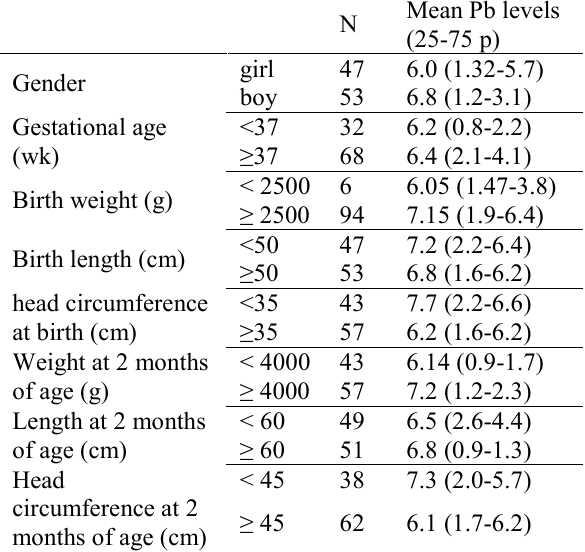
Table 4. Influence of selected infant factors on Pb